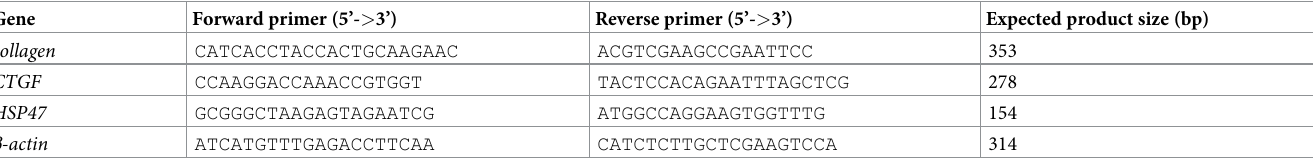
Table 1. Primers for the reverse transcription polymerase chain